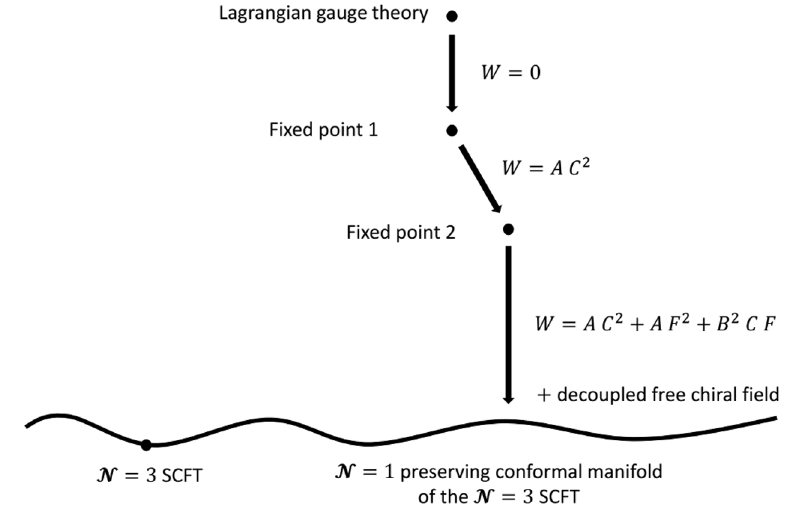
Figure 2 . A pictorial summary of the proposed relation between the Lagrangian gauge theory studied in this section and the N = 3 SCFT. Here the arrows represent RG (cid:13)ows, with the initial one being triggered by the asymptotically free gauge couplings, and the others by superpotential terms. Here at the end point of the (cid:13)ow there is also a decoupled free chiral (cid:12)eld, as indicated by the text